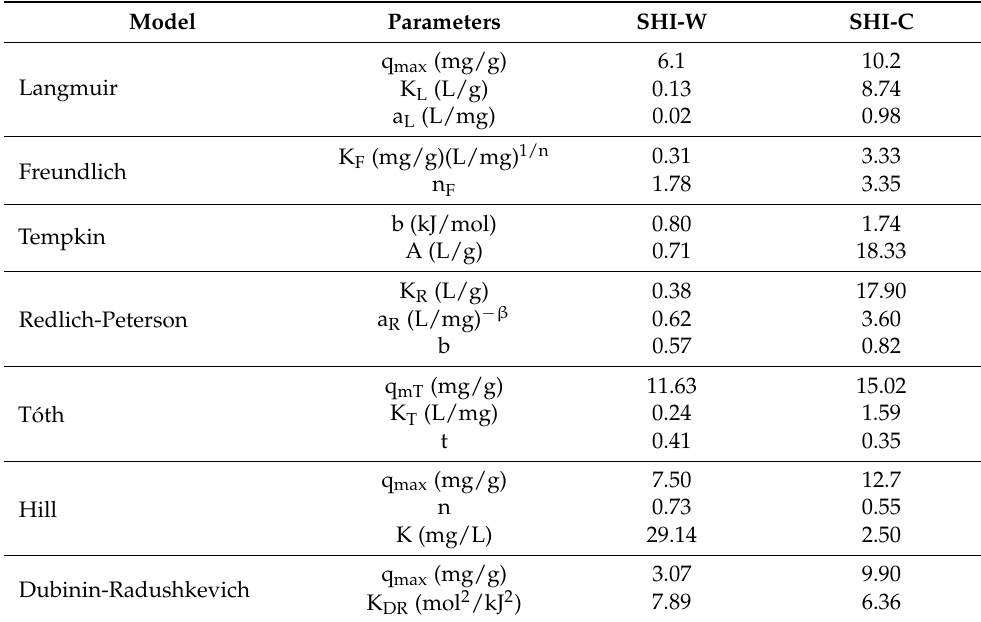
Table 3. Isotherm parameter constants for copper adsorption onto washed (SHI-W) and Na 2 CO 3 activated (SHI-C) hemp shives obtained using seven common isotherm